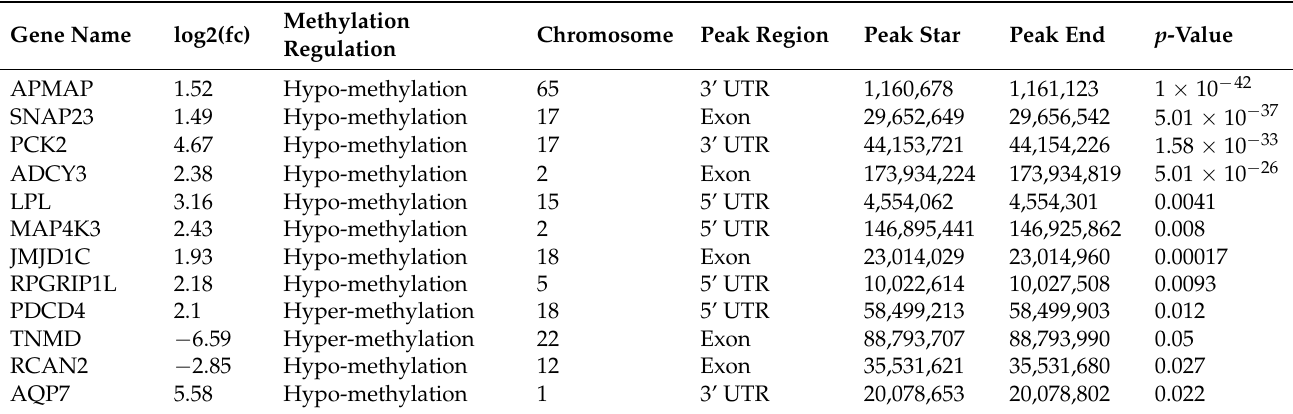
Figure 3. Enrichment pathway of m 6 A peak related to fat deposition. Table 4. M 6 A peaks of 12 genes related to fat